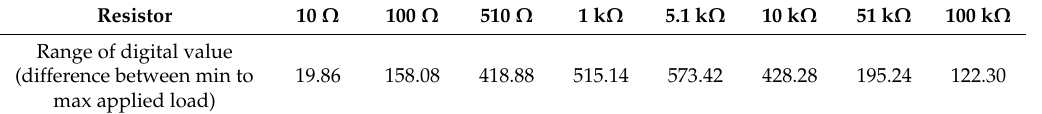
Figure 9. Force variation Vs. Load for various resistors. Table 1. Range of digital value for load range between 0.5 N to 18.5 N